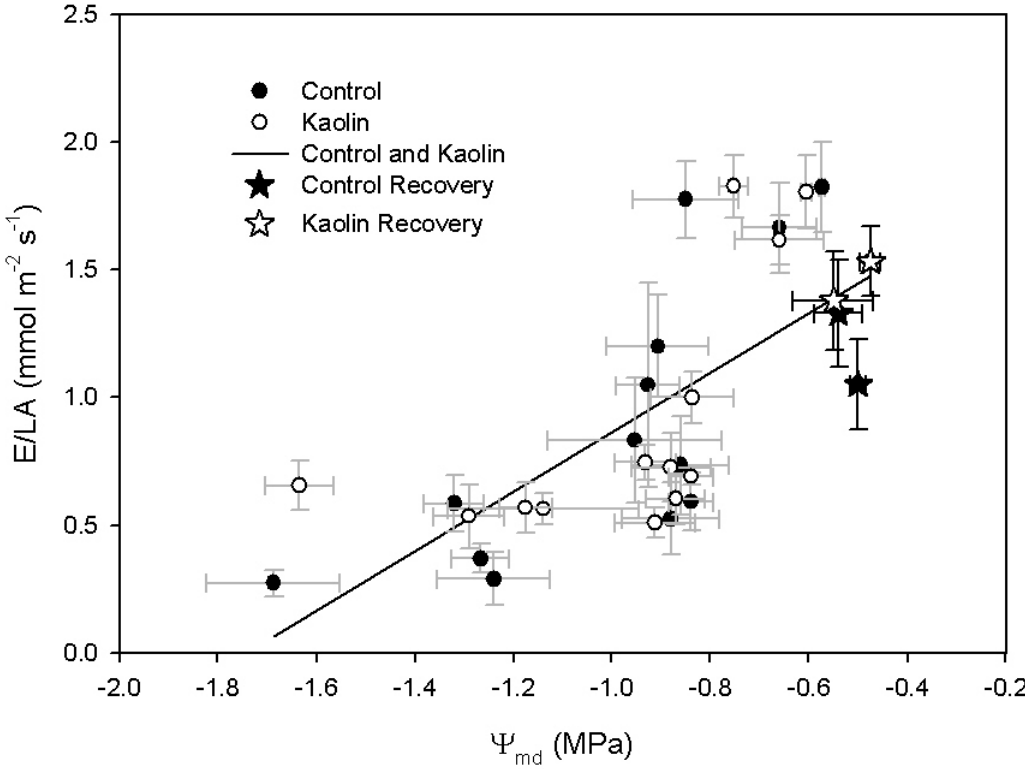
Figure 2. Correlation between whole-canopy transpiration rate / leaf area (E / LA) and midday stem water potential ( Ψ MD ).